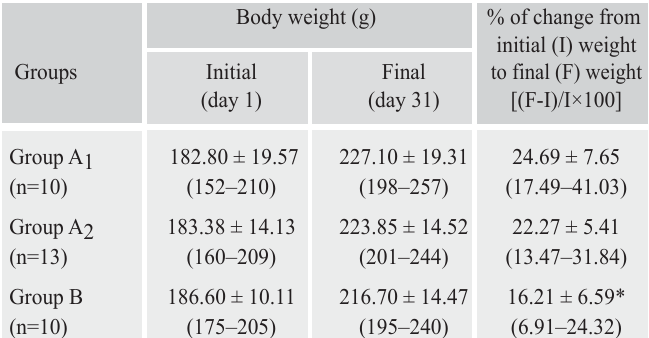
Table I: Initial and final body weight of rats and percentage of change of body weight in different groups (n=33)